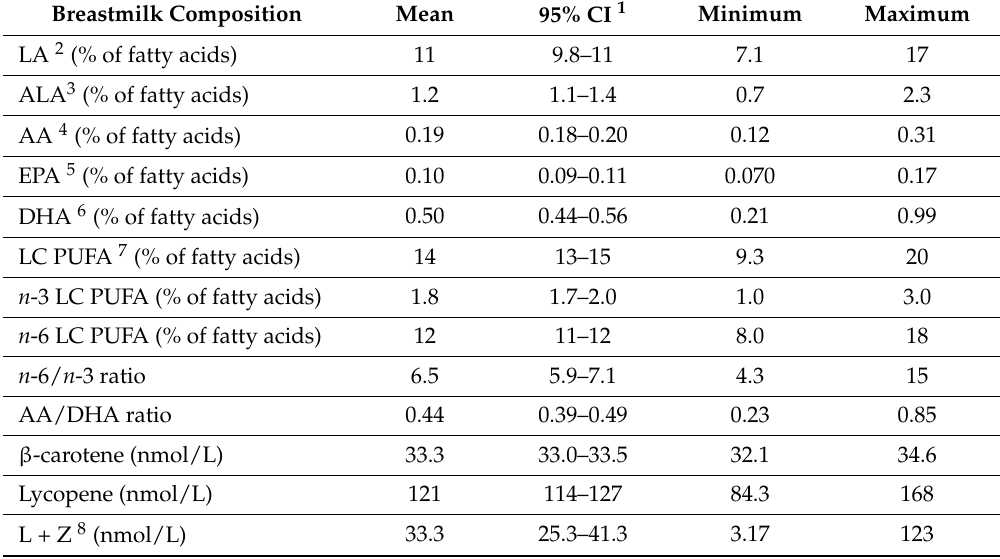
Table 3. The average concentration of selected LC PUFA and carotenoids in breastmilk from the first and third months of lactation.